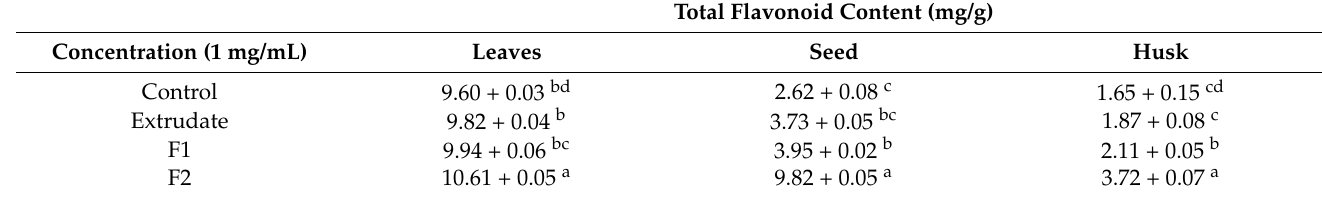
Table 3. Total flavonoid contents of the control, extrudate, F1 and F2 formulation of M. oleifera (leaves, seed, and